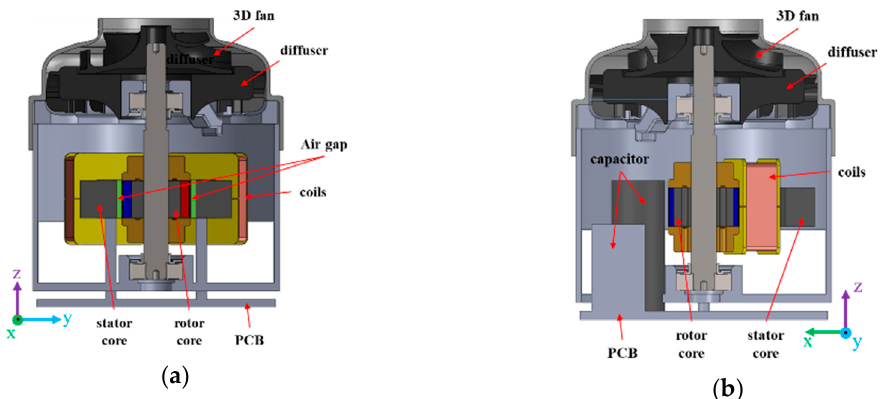
Figure 12. Cross-sectional view of motor assembly: ( a ) plane of y-z; ( b ) plane of x-z.